Question: Express in one sentence what the figure is showing.
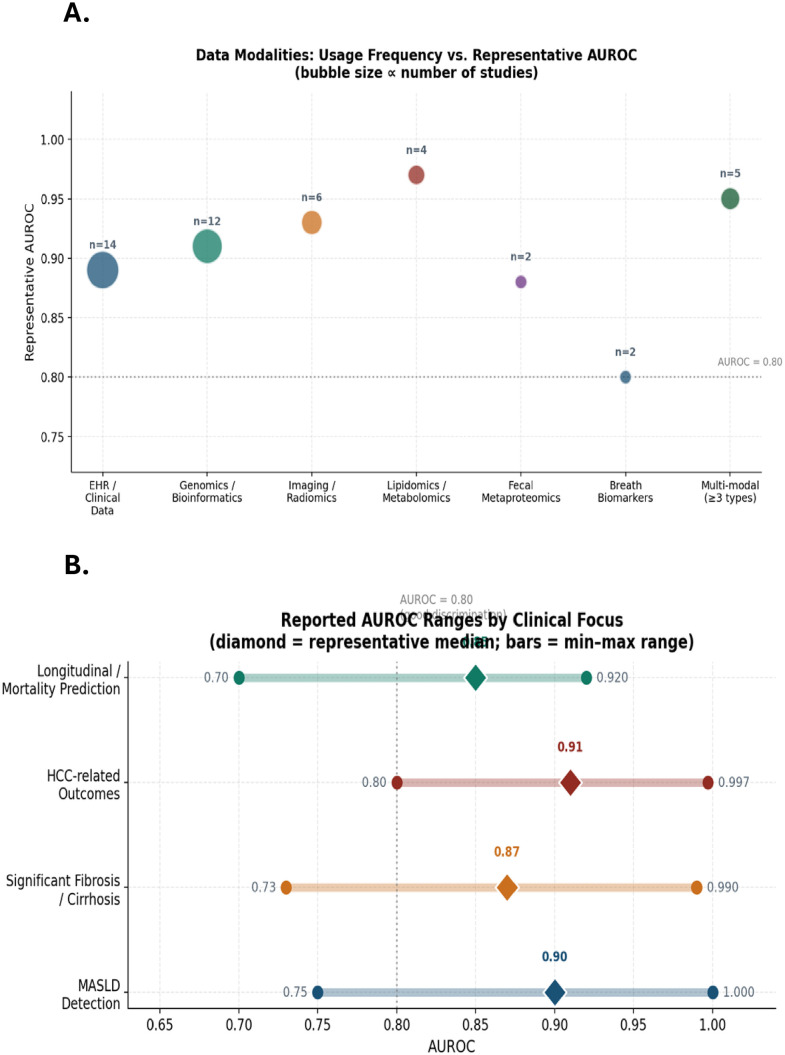
Answer: (A) Data modality frequency versus representative AUROC. Bubble size is proportional to the number of studies using each modality. EHR/clinical data and genomics/bioinformatics were the most frequently applied. Lipidomics/metabolomics achieved the highest representative AUROCs (up to 0.997), though typically in smaller single-centre cohorts. Novel modalities (breath biomarkers, fecal metaproteomics) were emerging and exploratory. (B) Reported AUROC ranges by clinical focus category. Diamonds denote representative median AUROC; horizontal bars represent min-max observed range. MASLD detection showed the widest range (0.75-1.00), reflecting heterogeneity in modality and cohort size. Fibrosis/cirrhosis and HCC studies achieved comparable or superior median AUROCs, while longitudinal mortality prediction demonstrated the widest downward spread (AUROC reaching 0.70 in external validation).